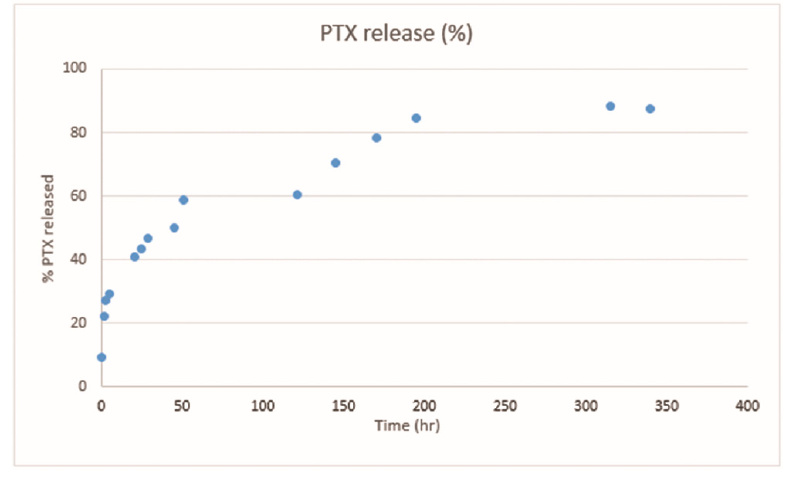
Figure 13. Percentage of released PTX plotted against time (hours). Data were obtained with UV-Vis experiments performed on SPION6 (see Figure